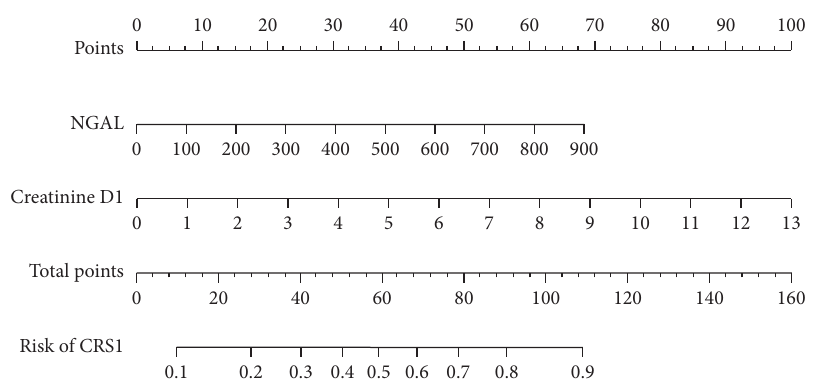
Figure 3: Nomogram in predicting CRS1 of plasma NGAL and creatinine